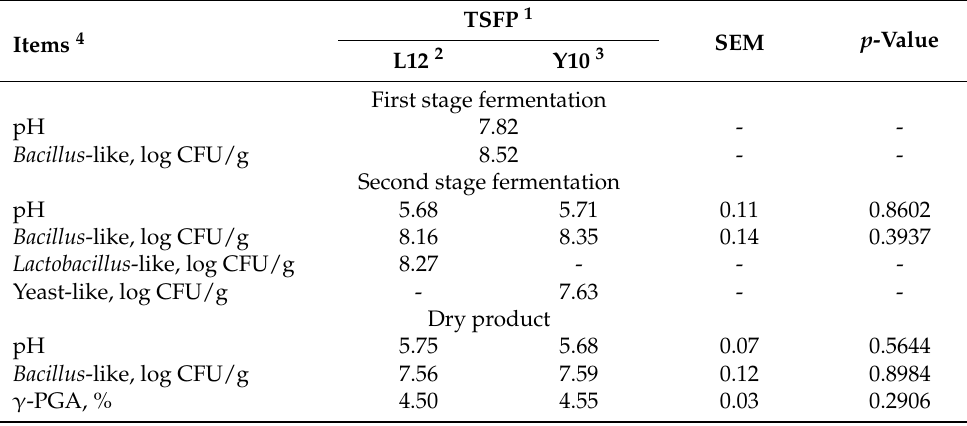
Table 2. Physical and chemical analysis of two-stage fermented